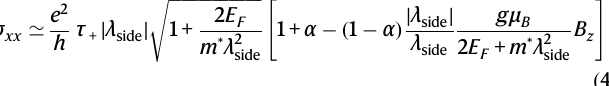
locked to the momentum k x in opposite directions between the green and pink bands. Electron scattering between the 1D and 2D channels occurs mainly between bands with the same chirality, as indicated by the red and blue arrows. In the 2D channel, MPE opens the gap ( Δ 2D ) between two bands with opposite z spin components ( σ z ). Different density of states between the two (pink and green) 2D bands leads to different relaxation times τ + and τ − in the 1D channel. c Calculated results of the OMR using Eq. (4) with α =0.1, E F =100meV, m * λ 2 side =0.45meV 28 , and Δ z / B z =0.52meV/T for g =18 27 . The sign of the Rashba parameter λ side determines the polarity of the OMR component in the 1D sys- tem. d , e OMR as functions of α (with E F =100meV) and E F (with α =0.1), respectively. α (= τ − / τ + ) represents the different relaxation times of electron carriers in the E − and E + states; α is small in the case of a strong MPE. A strong MPE and a small α lead to a large